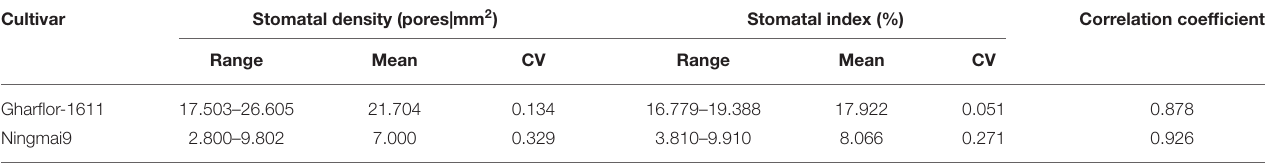
TABLE 4 | Summary of the stomatal index and stomatal density characters of two wheat varieties. Cultivar